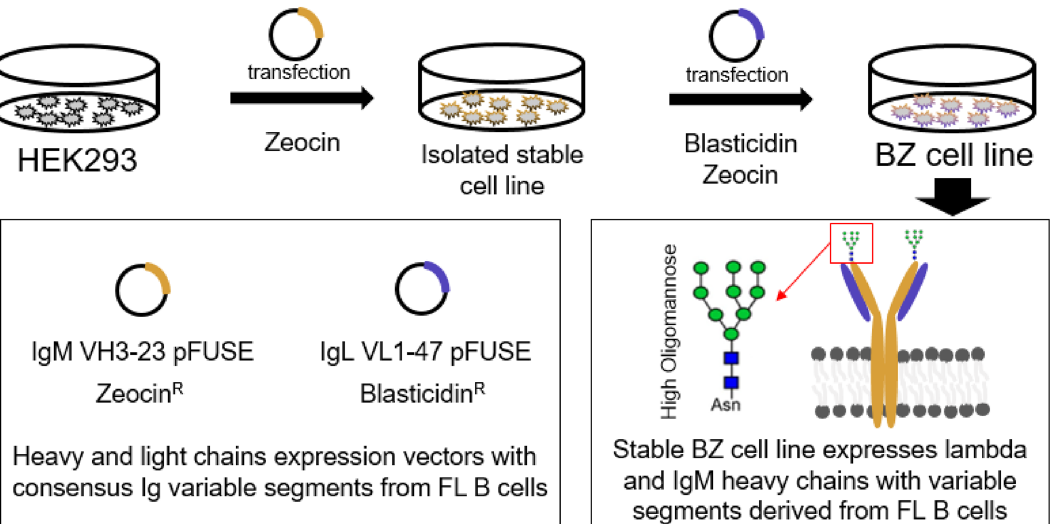
Figure 7. Schematic of process for generating engineered BZ cell line. ( A ) Expression vectors based of pFUSE were constructed with variable segments derived from consensus deep sequencing results of follicular lymphoma B cells. Sequential isolation of stable cell lines under antibiotic selection and examination of expression were carried out to identify the BZ cell line which provided the surface display of antibody possessing the FL B cell derived variable